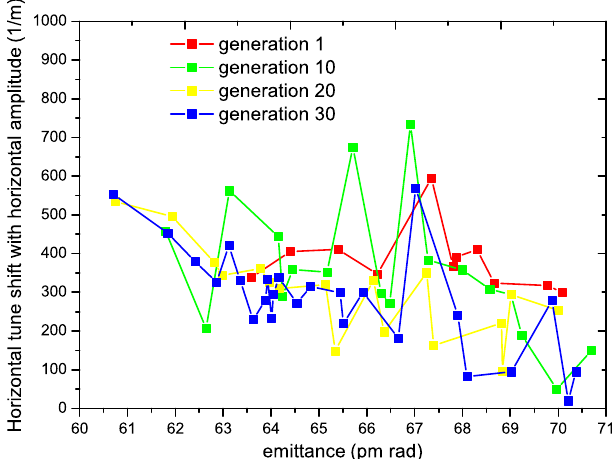
generation.FIG. 8. The horizontal tune shift with horizontal amplitude. The different color means the optimal solutions obtained at different